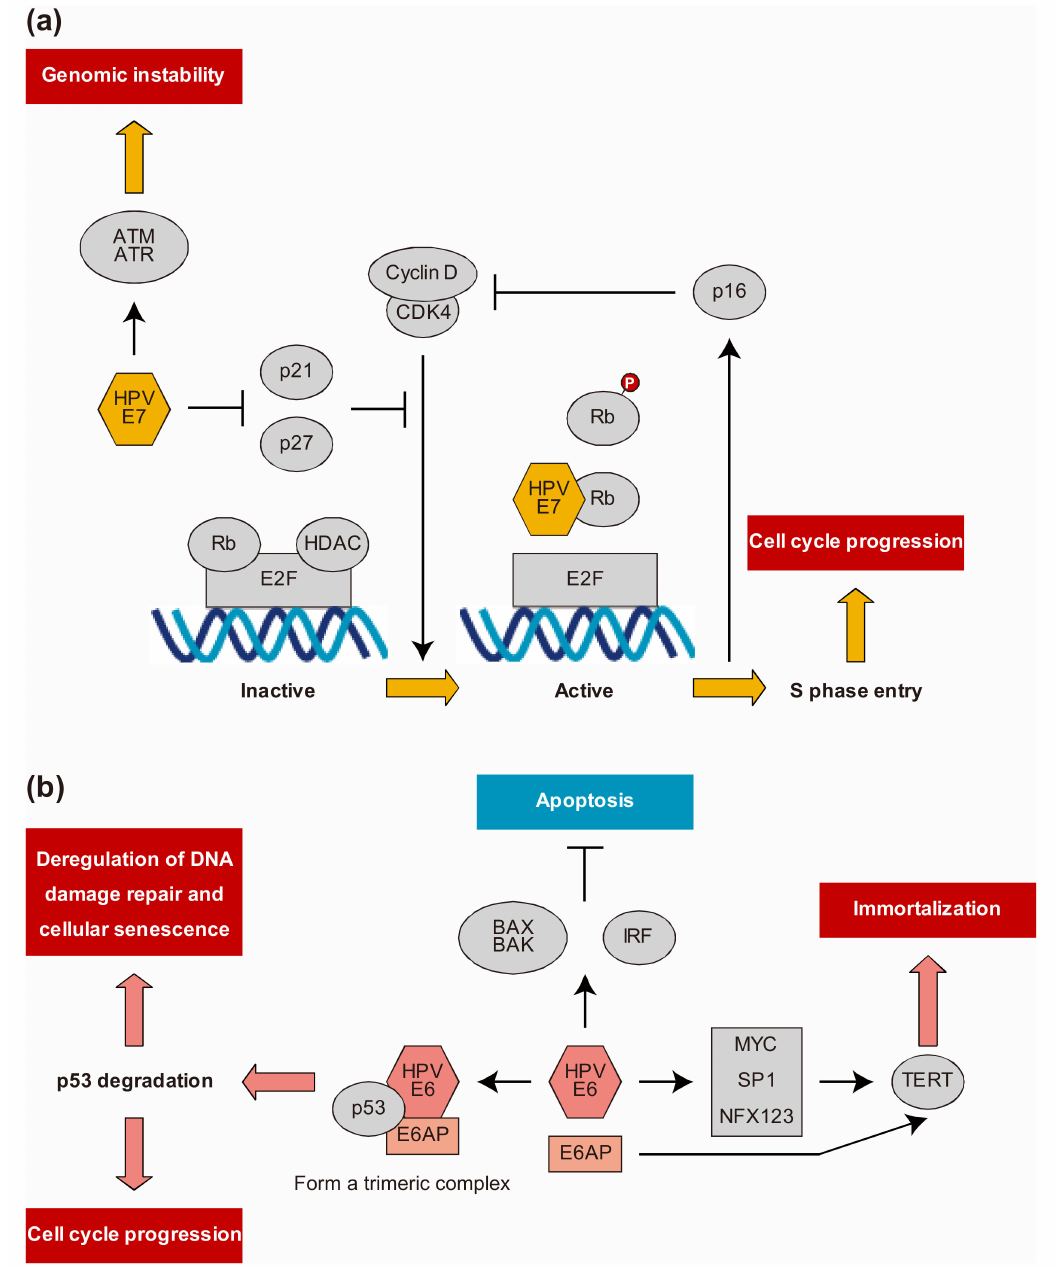
Figure 2. ( a ) Role of human papillomavirus (HPV) E7 oncoprotein in the progression to cancer. HR HPV E7 protein targets retinoblastoma (Rb) family members for degradation, resulting in the release and activation of E2F transcription factors that drive the expression of S phase genes as well as induction of hyperproliferation. E7 can also induce cellular proliferation through deregulation of cyclin-dependent kinase (CDK) inhibitors p21 and p27, leading to direct activation of CDK2. Degradation of Rb family members by HPV E7 protein leads to p16 overexpression, inhibiting the ability of CDK4 to interact with cyclin D and stimulating passage through the G 1 phase of the cell cycle. ( b ) Role of HPV E6 oncoprotein in the progression to cancer. HR-HPV E6 inhibits p53-dependent growth arrest, resulting in the induction of genomic instability and the accumulation of cellular mutations. HR HPV E6 protein binds to cellular ubiquitin ligase E6AP to form a trimeric complex with p53, leading to the ubiquitylation and proteasomal degradation of p53 and the inhibition of p21. E6 also activates telomerase reverse transcriptase (TERT) and telomerase, resulting in cell proliferation and promoting